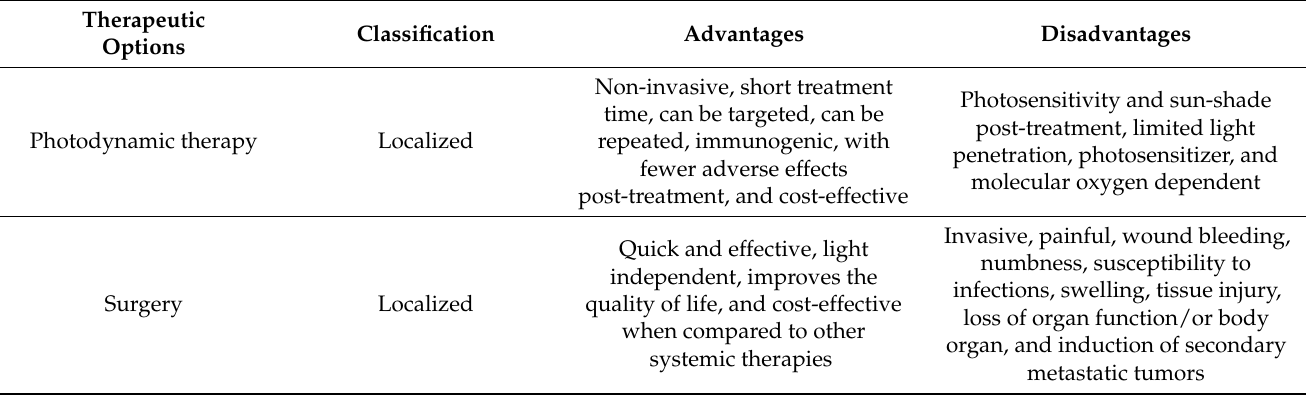
tional therapies for cancer treatment